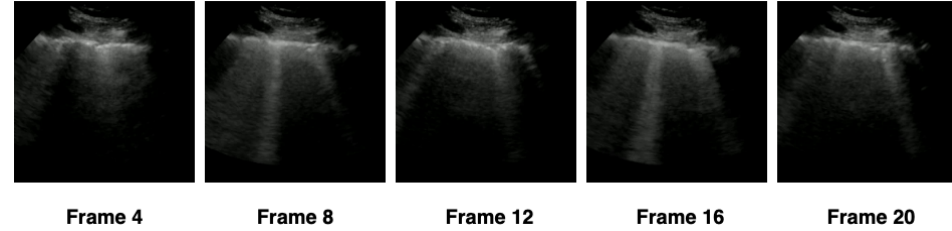
Figure 6. Samples of how the 5 frames were considered on configuration 1 of Table 4. The frames belong to a video whose patient was diagnosed with COVID-19.